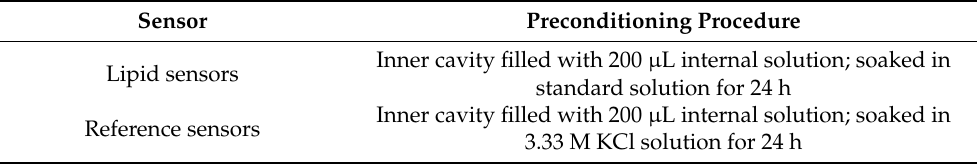
Table A2. Preconditioning procedures for different lipid membrane